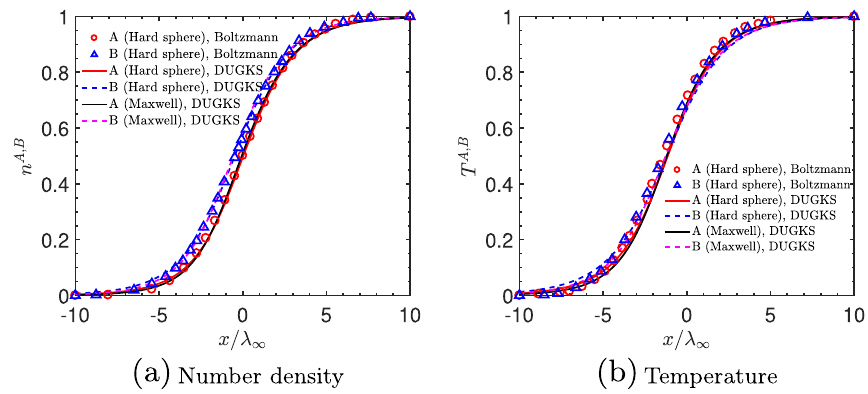
Fig. 9 Shock structure of different molecular models with Ma − = 1.5 , m B ∕ m A = 0.5 , and 𝜒 A =